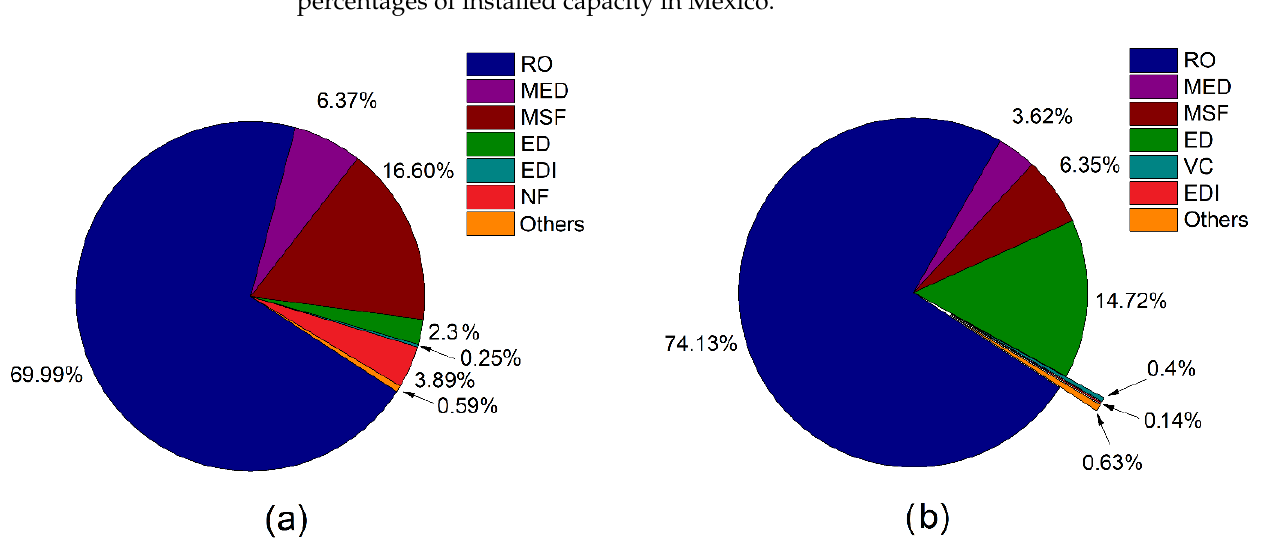
Figure 3. Number of desalination plants per state in Mexico, 2022.